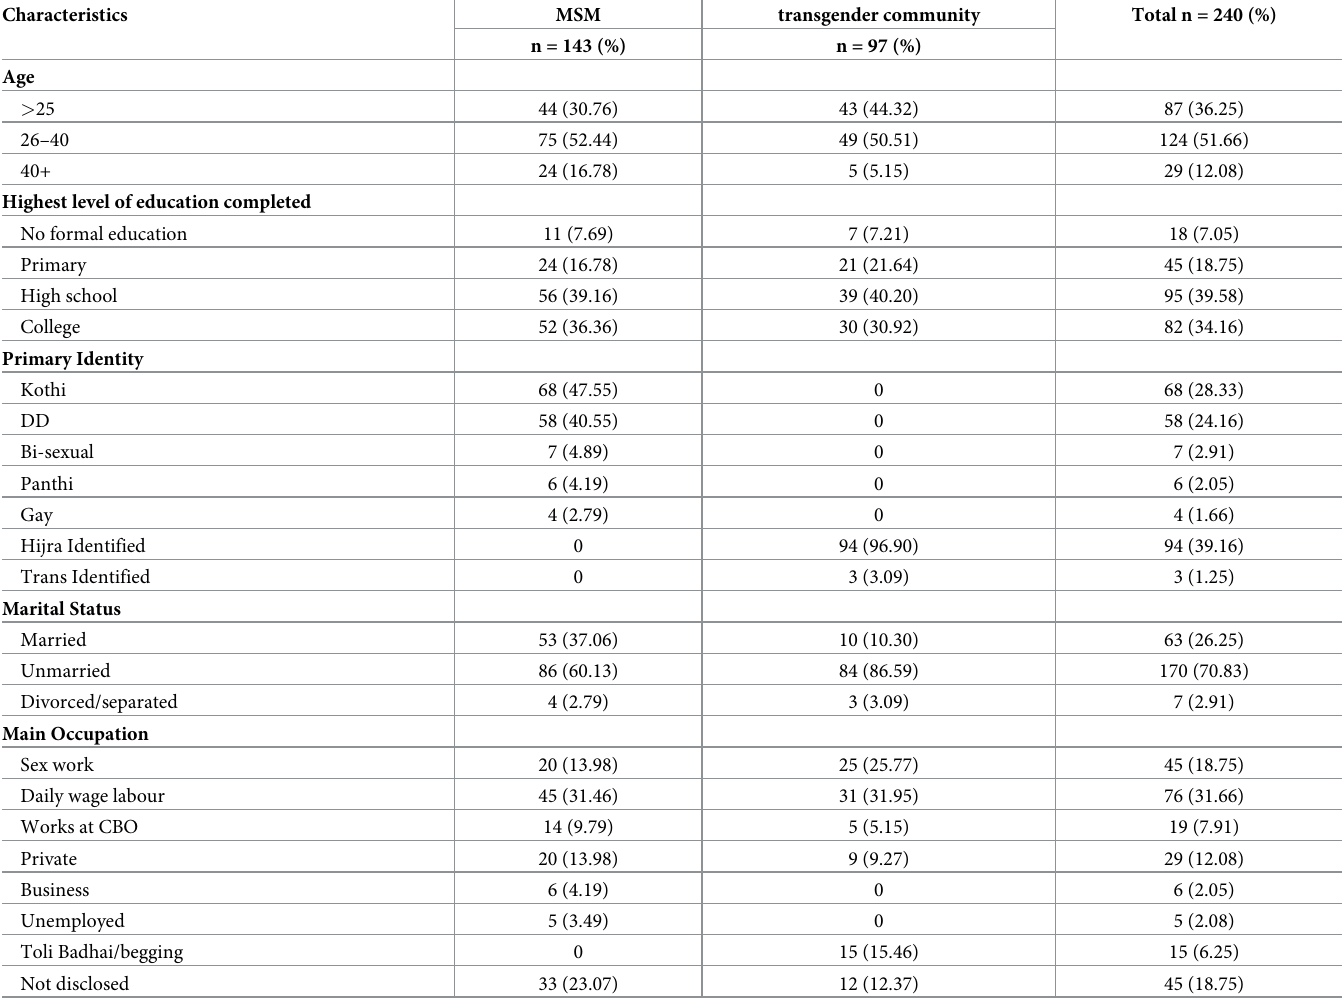
Table 1. Sociodemographic characteristics of MSM and transgender communities in IDI and FGD (n = 240).